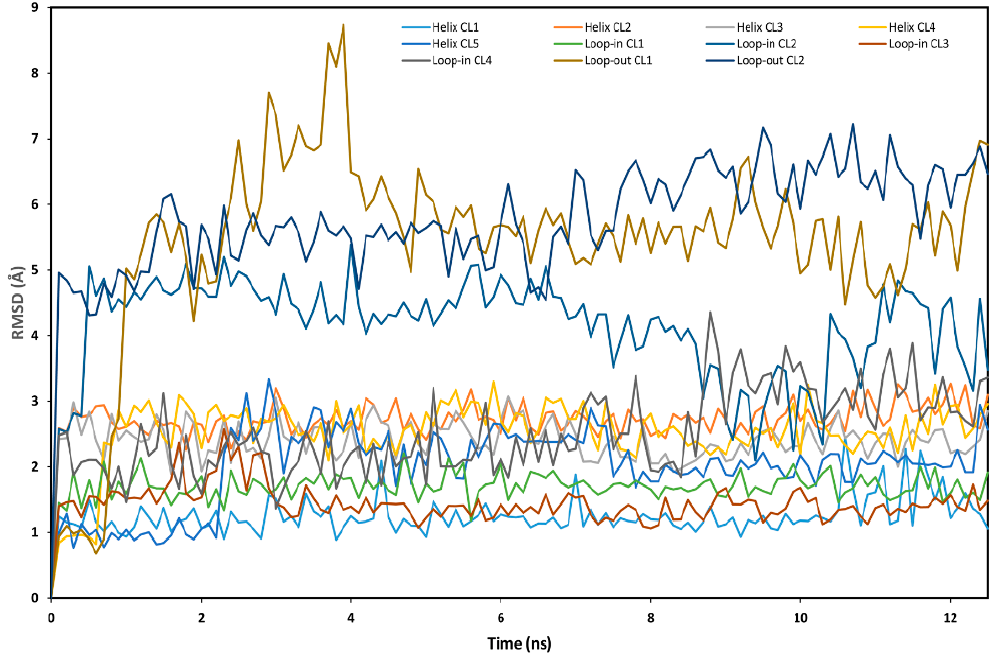
Figure 7. Analysis of the MD simulations of the eleven different Hsp90/HAA 2021 complexes. The RMSD of the position of the ligand with respect to its initial docking pose is shown.